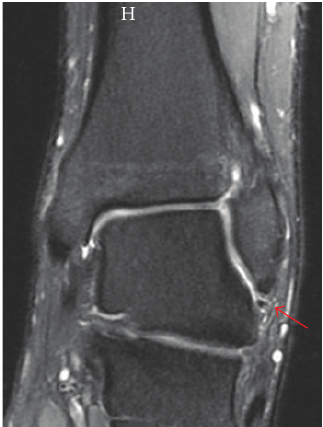
Figure 4: Coronal proton density fat saturated MR image showing an ATFL tear (arrow).